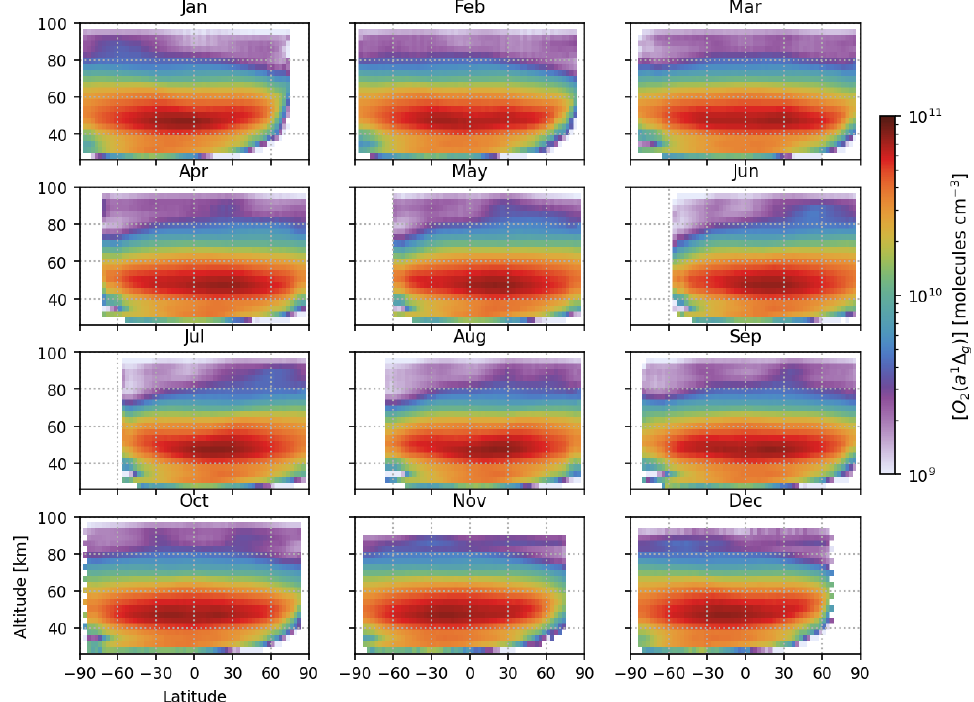
Figure 10. Vertical–latitudinal distribution of [ O 2 (a 1 (cid:49) g ) ] . Each data point in the retrieved profiles is binned to 3D grid boxes with sizes of 3 ◦ × 3 ◦ × 3.2km and then averaged zonally.